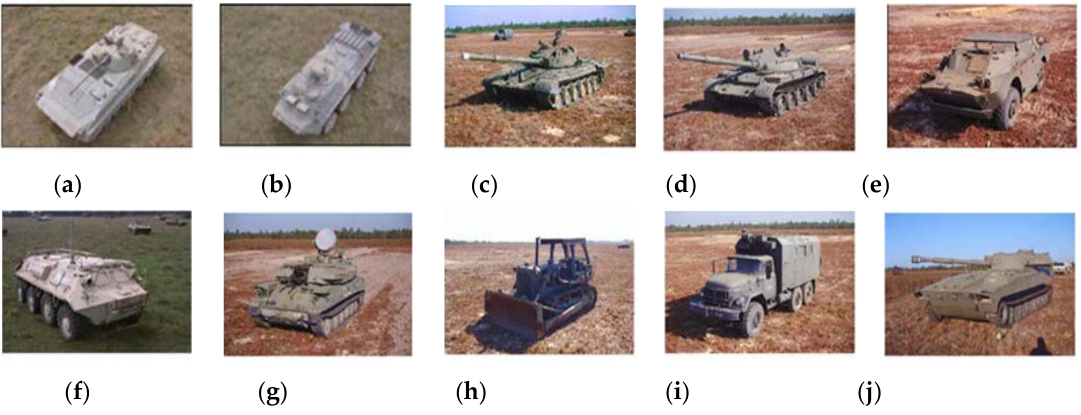
274 Table 2. Reference methods for comparison. SVM: support vector machine; SRC: sparse representation-based classification; CNN: convolutional neural network; PCA: principal component analysis. Abbrev. Ref.